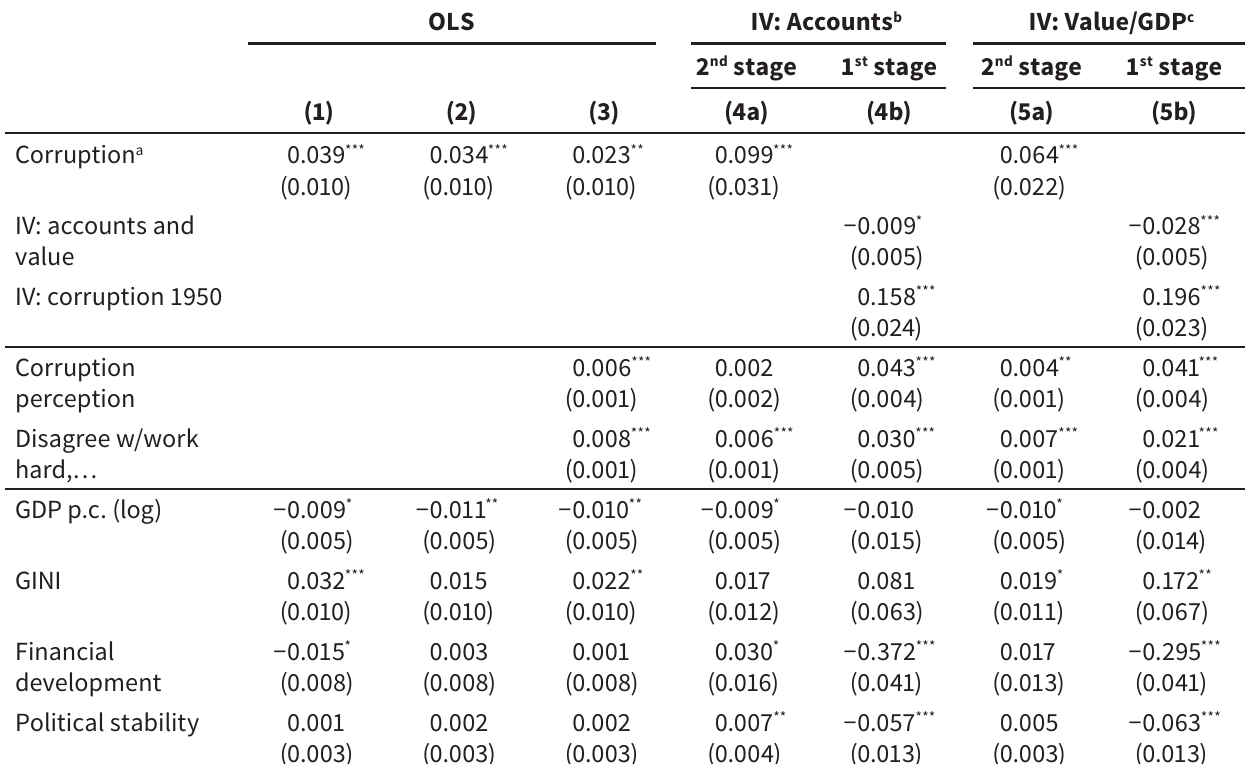
Full regression table for plans to emigration within the next 12 months (inverse of WGI corruption